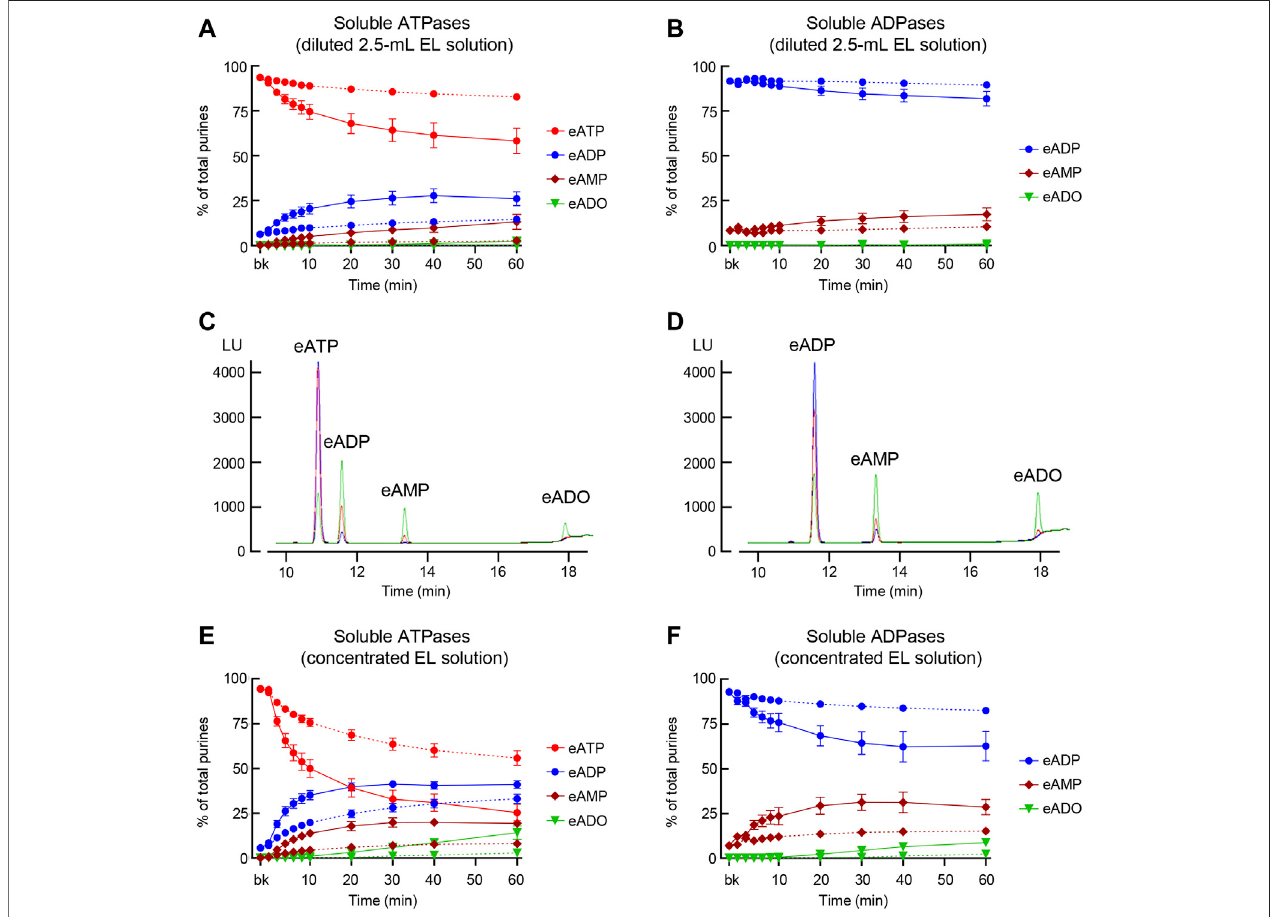
FIGURE 5 | Degradation ofeATPand eADPbysoluble enzymesreleasedintheLPatrestand duringbladder fi lling. (A) Summarizeddatashowingthe degradationof eATP in diluted (i.e., 2.5-ml) EL samples collected at different time points during 1 h after addition of eATP in the absence of bladder preparation (Protocol 2). eATP, eADP, eAMP,andeADOarepresentedaspercentagesoftotalpurines(eATP+eADP+eAMP+eADO)presentinELsolutionsamplesfromnondistended(dottedconnectinglines) anddistended(solidconnectinglines)preparations. (B) SummarizeddatashowingthedegradationofeADPindiluted(i.e.,2.5-ml)ELsamplescollectedatdifferenttime pointsduring 1 h after additionofeADP inthe absence ofbladder preparation (Protocol 2). eADP,eAMP, and eADOare presented aspercentages oftotal purines(eADP+ eAMP+eADO)presentinELsolutionsamplesfromnondistended(dottedconnectinglines)anddistended(solidconnectinglines)preparations. (C) Originalchromatograms of eATP in beaker (blue) and at 60 min of addition of eATP to concentrated EL samples (Protocol 3) collected from nondistended (red) and distended (green) bladder preparations. The chromatograms demonstrate greater decreaseofeATPand increaseineADP, eAMP, and eADOin ELsolutions fromdistended than fromnondistended preparations. (D) Originalchromatograms ofeADPinbeaker(blue) and at60 minofaddition ofeADP toconcentratedELsamples (Protocol3)collected fromnondistended (red) and distended (green) bladder preparations. The chromatograms demonstrate greater decrease of eADP and increase in eAMP and eADO in EL solutions from distended than from nondistended preparations. (E) Summarized data showing the degradation of eATP in EL samples collected at different time points during 1 h after additionofeATPinconcentratedELsamplescollected fromnondistended(dottedconnectinglines)anddistended (solid connectinglines)(Protocol3).eATP,eADP, eAMP, andeADOarepresentedaspercentagesoftotalpurines(eATP+eADP+eAMP+eADO)presentintheELsolutionsamples. (F) Summarizeddatashowingthedegradation ofeADPinELsamplescollected atdifferent timepointsduring 1 h after additionofeADPinconcentratedELsamplescollected fromnondistended(dotted connectinglines) anddistended(solidconnectinglines)preparations(Protocol3).eADP,eAMP,andeADOarepresentedaspercentagesoftotalpurines(eADP+eAMP+eADO)presentinthe EL solution samples. Statistical signi fi cance is described in main text Results.